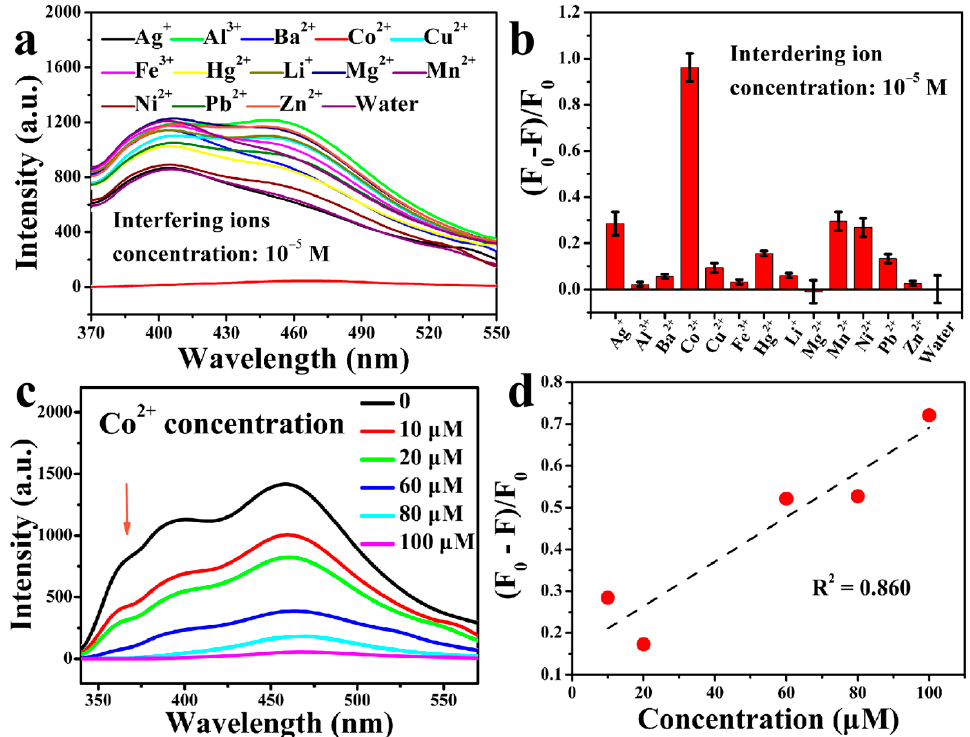
Figure 5. ( a ) The fluorescence intensity of CDs was weakened by different metal ions, i.e., Ag + , Al 3+ , Ba 2+ , Cu 2+ , Fe 3+ , Hg 2+ , Li + , Mg 2+ , Mn 2+ , Ni 2+ , Pb 2+ , Zn 2+ , and water at 320 nm excitation wavelength; ( b ) histogram of fluorescence decay of different metal ions for CDs; ( c ) the effect of different concentrations of 10 µ L Co 2+ ions on the fluorescence intensity of 3 mL CDs solution; ( d ) the linear relation of ( c